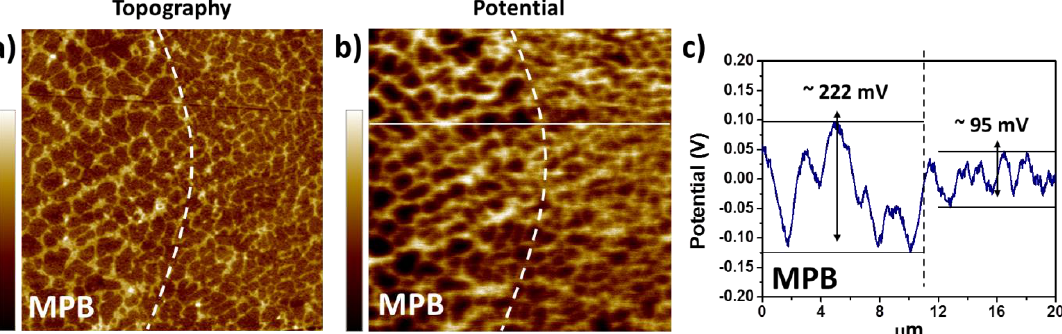
Figure 5. ( a ) Topography and ( b ) surface potential map (obtained by scanning Kelvin probe force microscopy—SKPFM) of an area on the surface of a polished AM AlSi10Mg specimen in which a melt pool border is visible (delimited by the discontinuous line). Scan size: 20 × 20 µm 2 . Colour bar: ( a ) 30 nm range, ( b ) 210 mV range. ( c ) Surface potential profile of the line represented in ( b ). (Adapted from